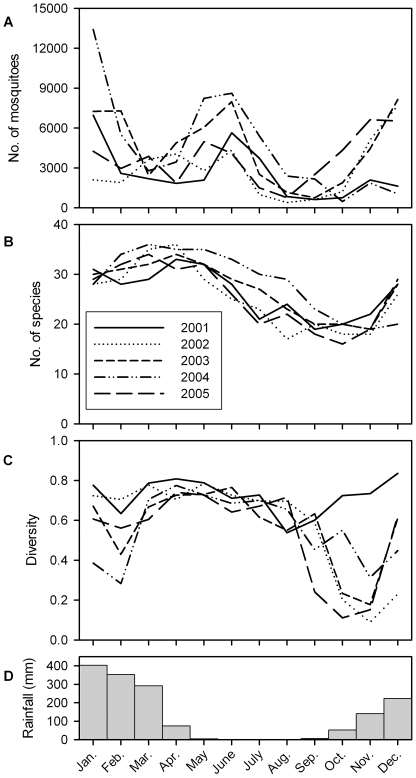
Trends in mosquito abundance over five years.Based on weekly sampling of 11 sites around the city of Darwin: (A) weekly average number of individuals; (B) total number of species; and (C) species diversity (Simpson's Diversity Index). Median monthly rainfall (68 years) is shown in (D) for comparison.